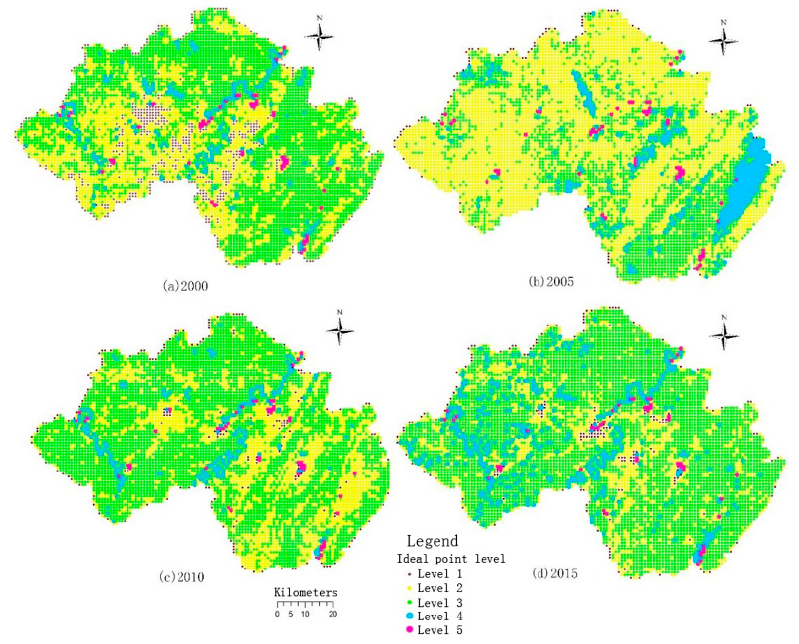
Figure 3. Grade map of ideal points in 2000, 2005, 2010, and 2015 [19].( a ) Grade map of ideal points in 2000 ( b ) Grade map of ideal points in 2005 ( c ) Grade map of ideal points in 2010 ( d ) Grade map of ideal points in 2015